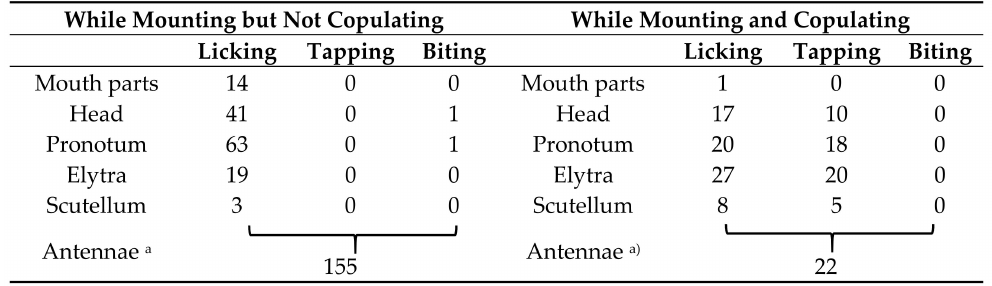
Table 2. Appeasement behavior of males toward females in Rosalia batesi : the frequency of each behavior and its